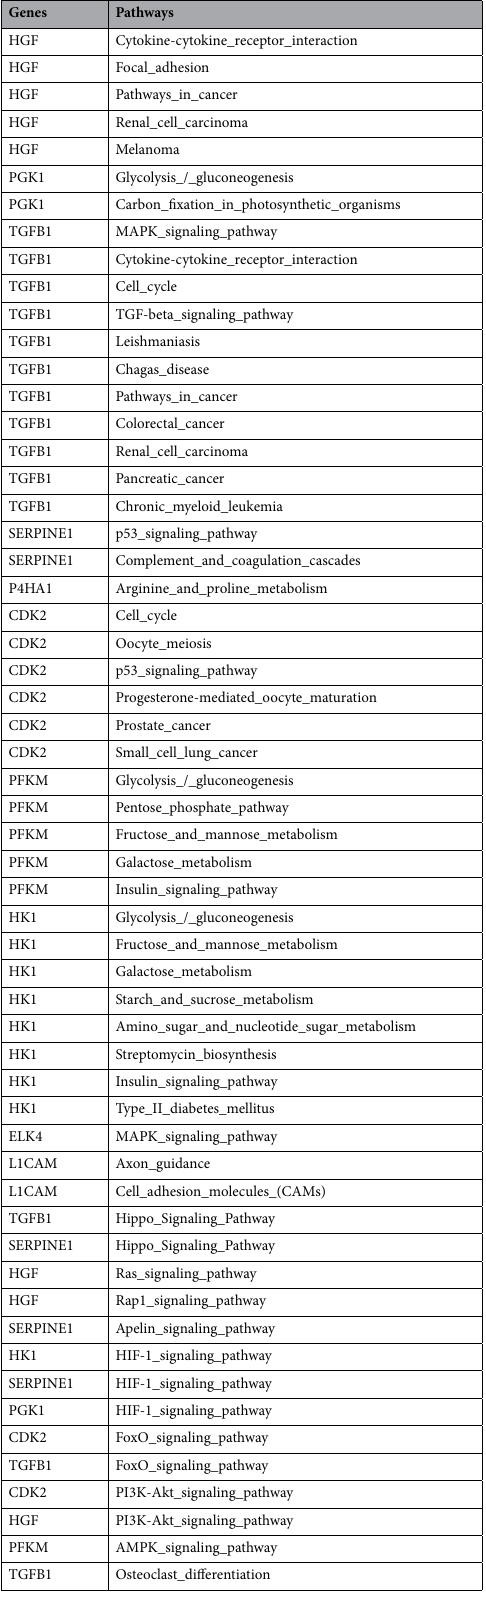
Table 1. Top hypoxic genes with p-values ≤ 0.0013 and the associated